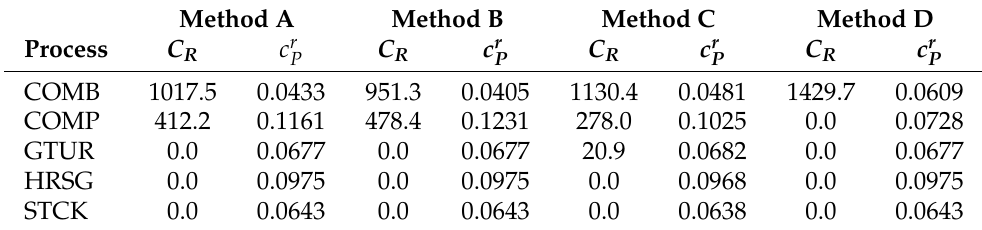
Table 12. Waste allocation cost using process thermoeconomics